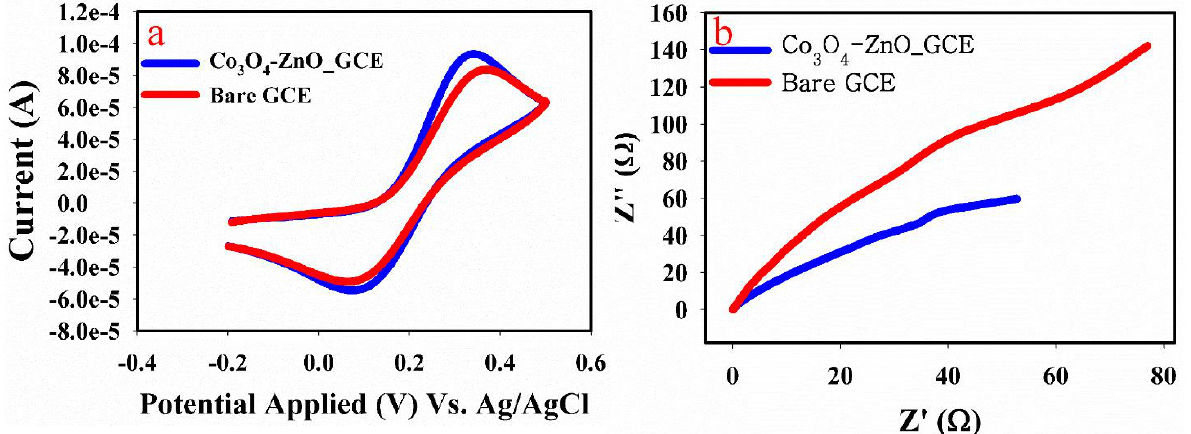
Figure 3. ( a ) Cyclic voltammetric response of Co 3 O 4 − ZnO nanorod modified GCE in 1 mM Fe (CN) 63 − /4 − at the scan rate of 75 mV/s. ( b ) EIS spectrum of Co 3 O 4 − ZnO nanorod in 0.1 M PBS 5.7/0.1 µM aspartic